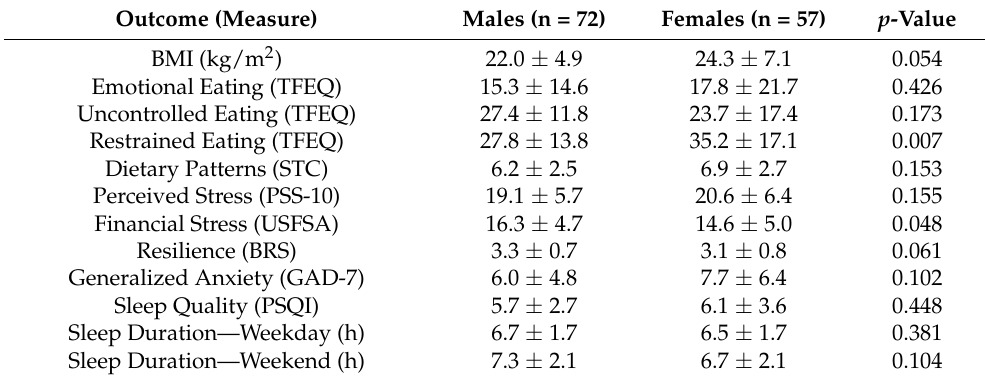
Table 1. Outcomes of interest by gender.